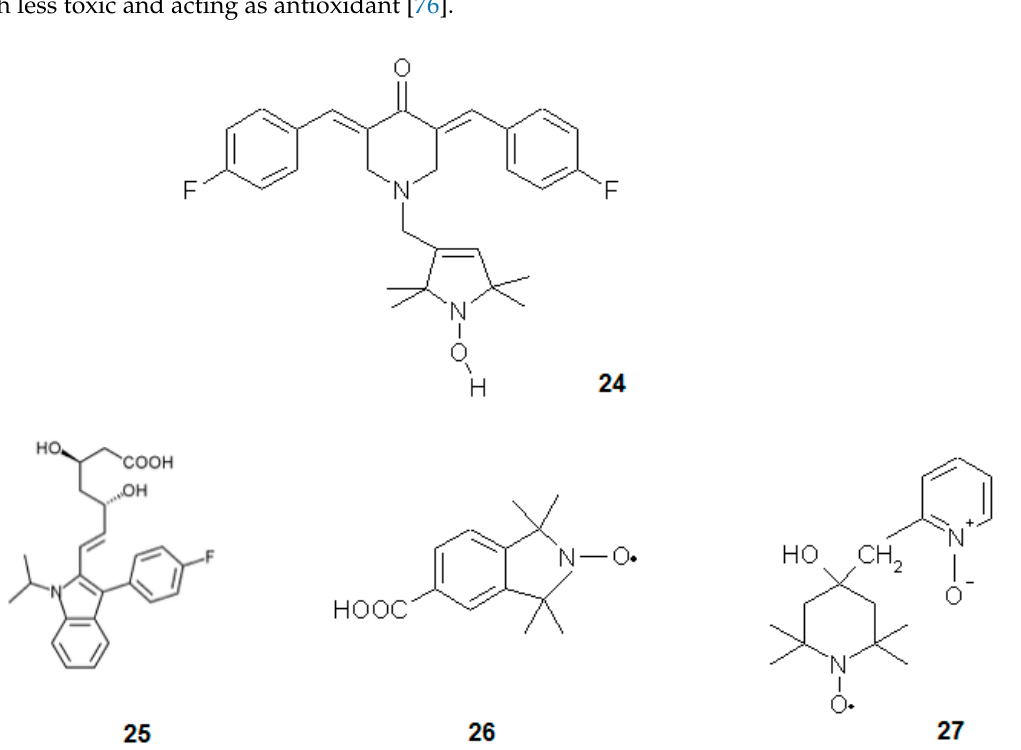
Figure 8. Nitroxides and other anticancer agents: ( 24 ) HO-3867, ( 25 ) fluvastatin, ( 26 ) CTMIO and ( 27 ) Tempicol-3.